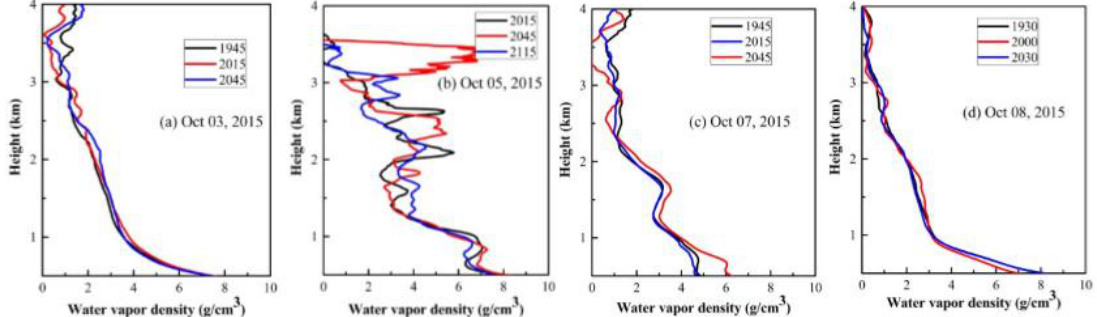
Figure 12. Several representative atmospheric water vapor density profiles during the rainfall process of 1–10 October 2015.